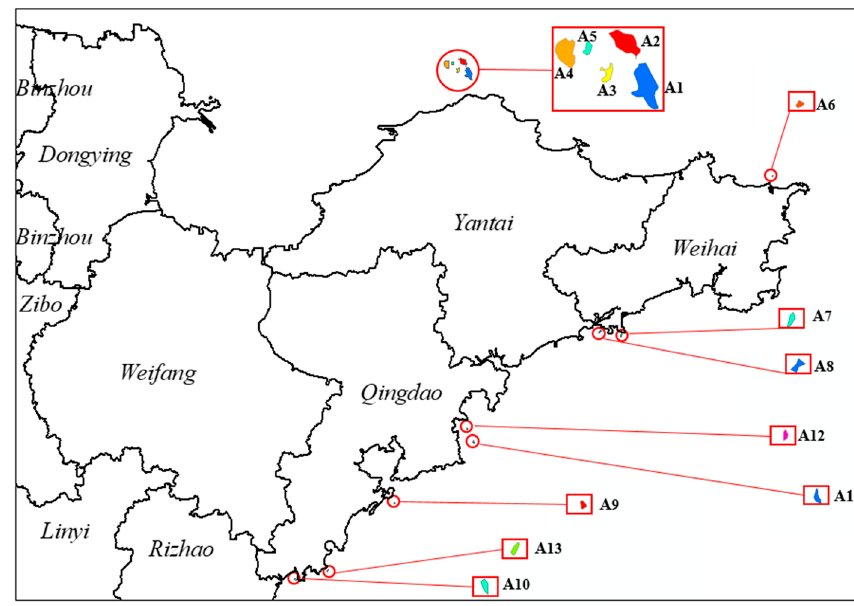
Figure 6. Thirteen island alternatives for constructing wave power plants.